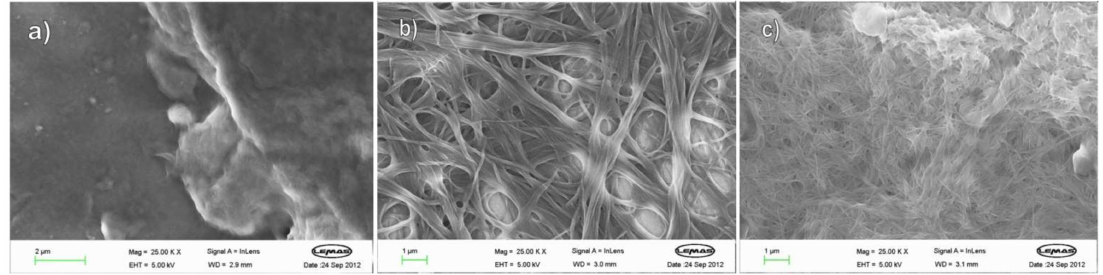
Figure 9. FEG-SEM images of xerogels formed by: ( a ) L,L,L and C8R; ( b ) D,D,D and C8R; ( c ) L,L,L + D,D,D and